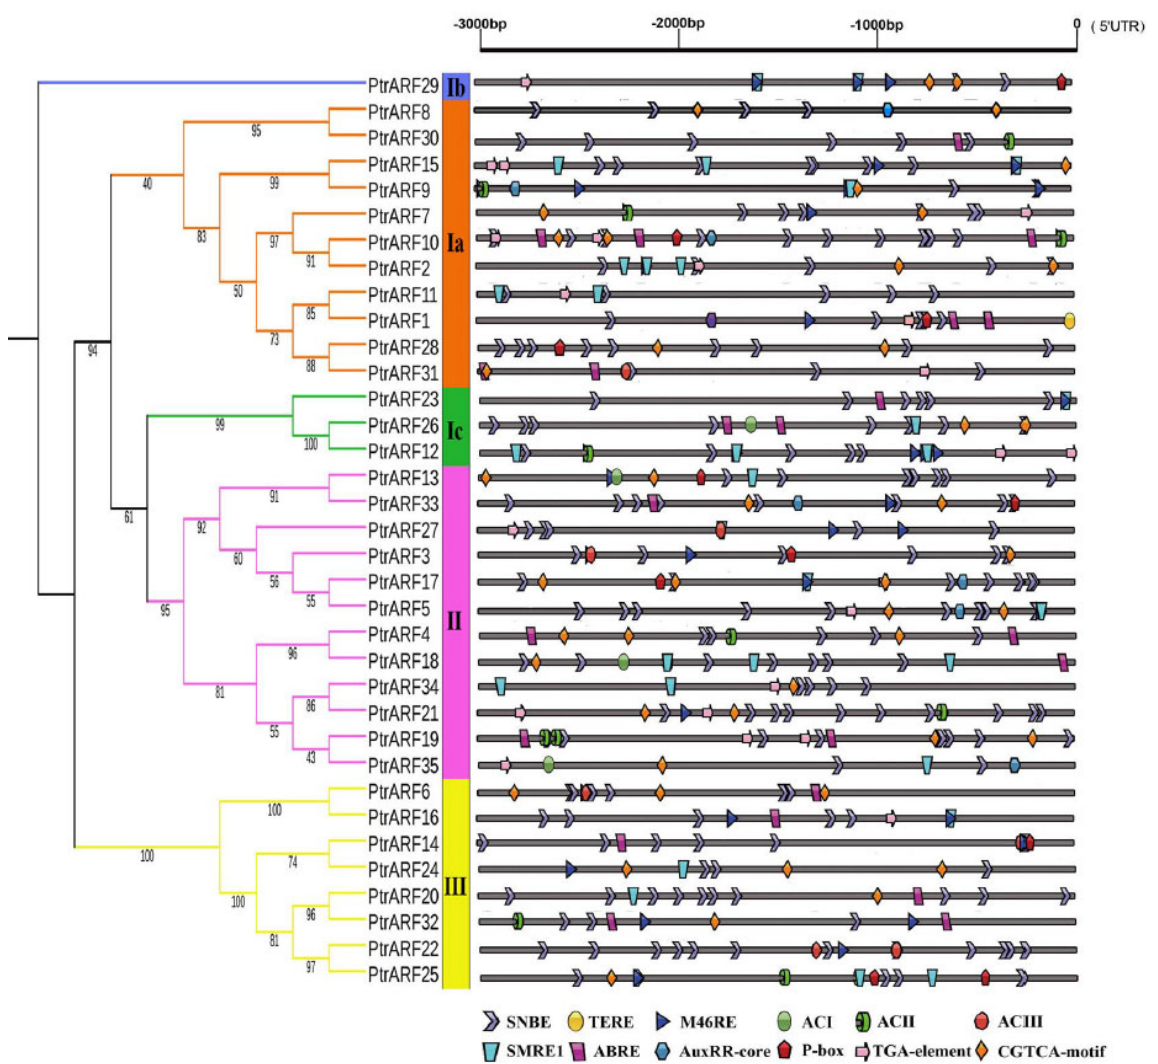
Figure 6. The cis -elements related to hormone response and xylem development in the promoters of 35 PtrARF genes. The 3000 bp promoter region (upstream DNA sequence of the 5 ′ UTR) of each PtrARF gene was analyzed for cis -elements. Different cis -elements are indicated by different diagrams.